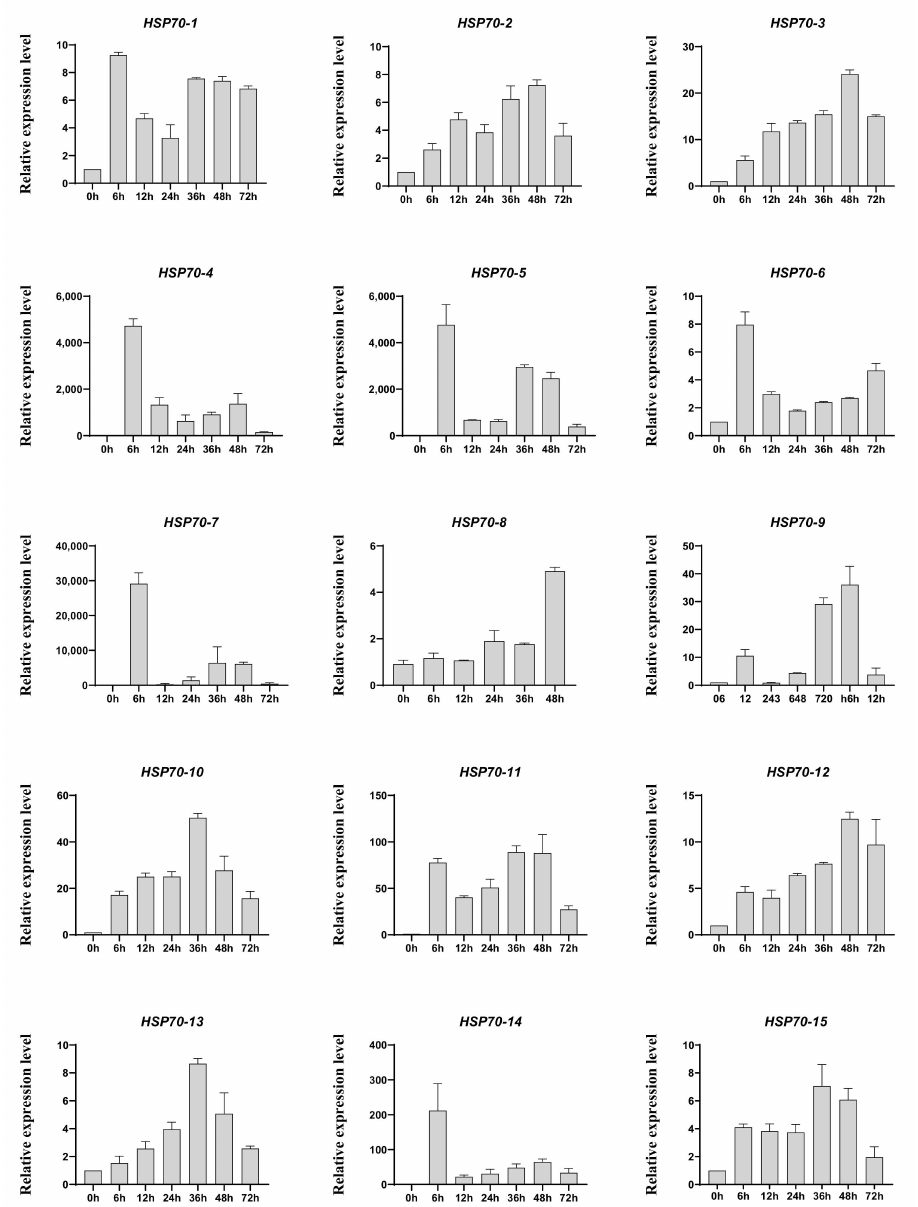
Figure 5. Expression profiles of AsHSP70s in heat treated calli. A. sinensis calli were transferred from 25 ◦ C to 42 ◦ C and sampled at appointed times (0 h, 6 h, 12 h, 24 h, 36 h, 48 h, 72 h). Expression levels of all detected genes were assayed using real-time PCR analysis and AsGADPH as the internal control. Each value is the mean ± SE of 3 independent biological